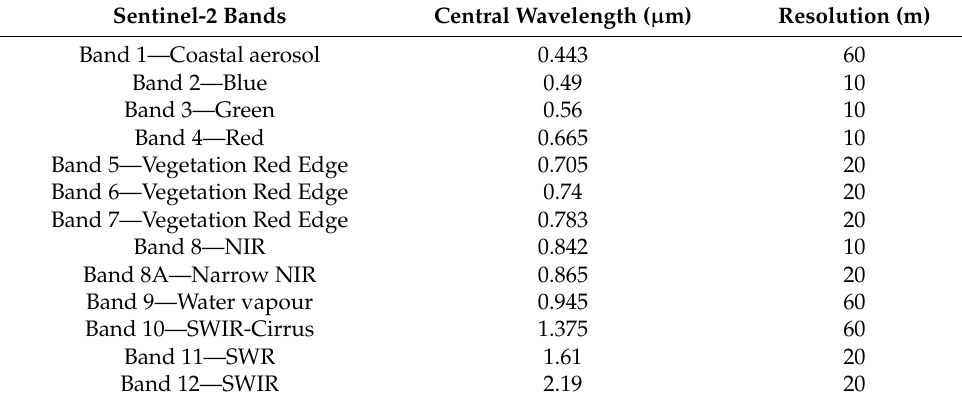
Table 1. Spectral properties of Sentinel-2 images.